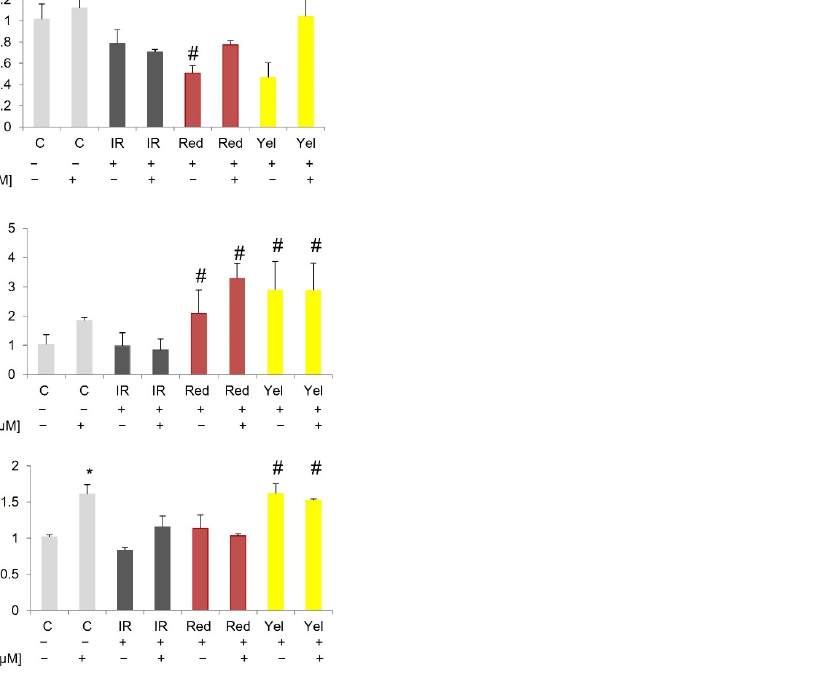
Figure 3. Gene expression in 3T3-L1 control adipocytes (C), insulin-resistant adipocytes (IR), and IR adipocytes treated with red and yellow (Yel) CM fruit extracts the concentration of 0.01 mg/mL. * p < 0.05 compared to the baseline (INS − ) of the appropriate group of cells, # p < 0.05 compared to the corresponding IR adipocytes (baseline INS − and after insulin stimulation INS+). Results have been presented as mean ± SD.